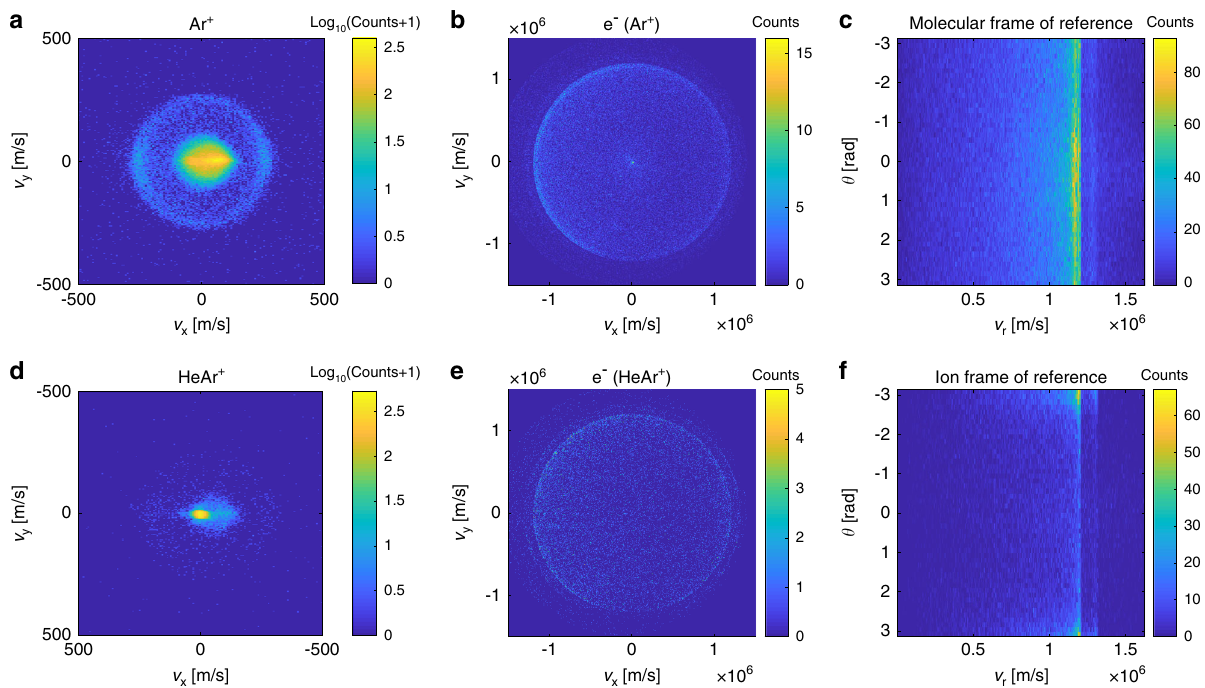
Fig. 3 VMI images. Coincidence VMI images of Ar + and HeAr + ( a , d ) and coincidence electrons ( b , e ). Ionic data are presented on a log scale to emphasize the outer circular feature which is the main interest of this paper. c , f Electron VMI images after rotation to the ionic frame of reference, where θ is de fi ned as the relative angle between the 2D velocities of the electron and the ion.